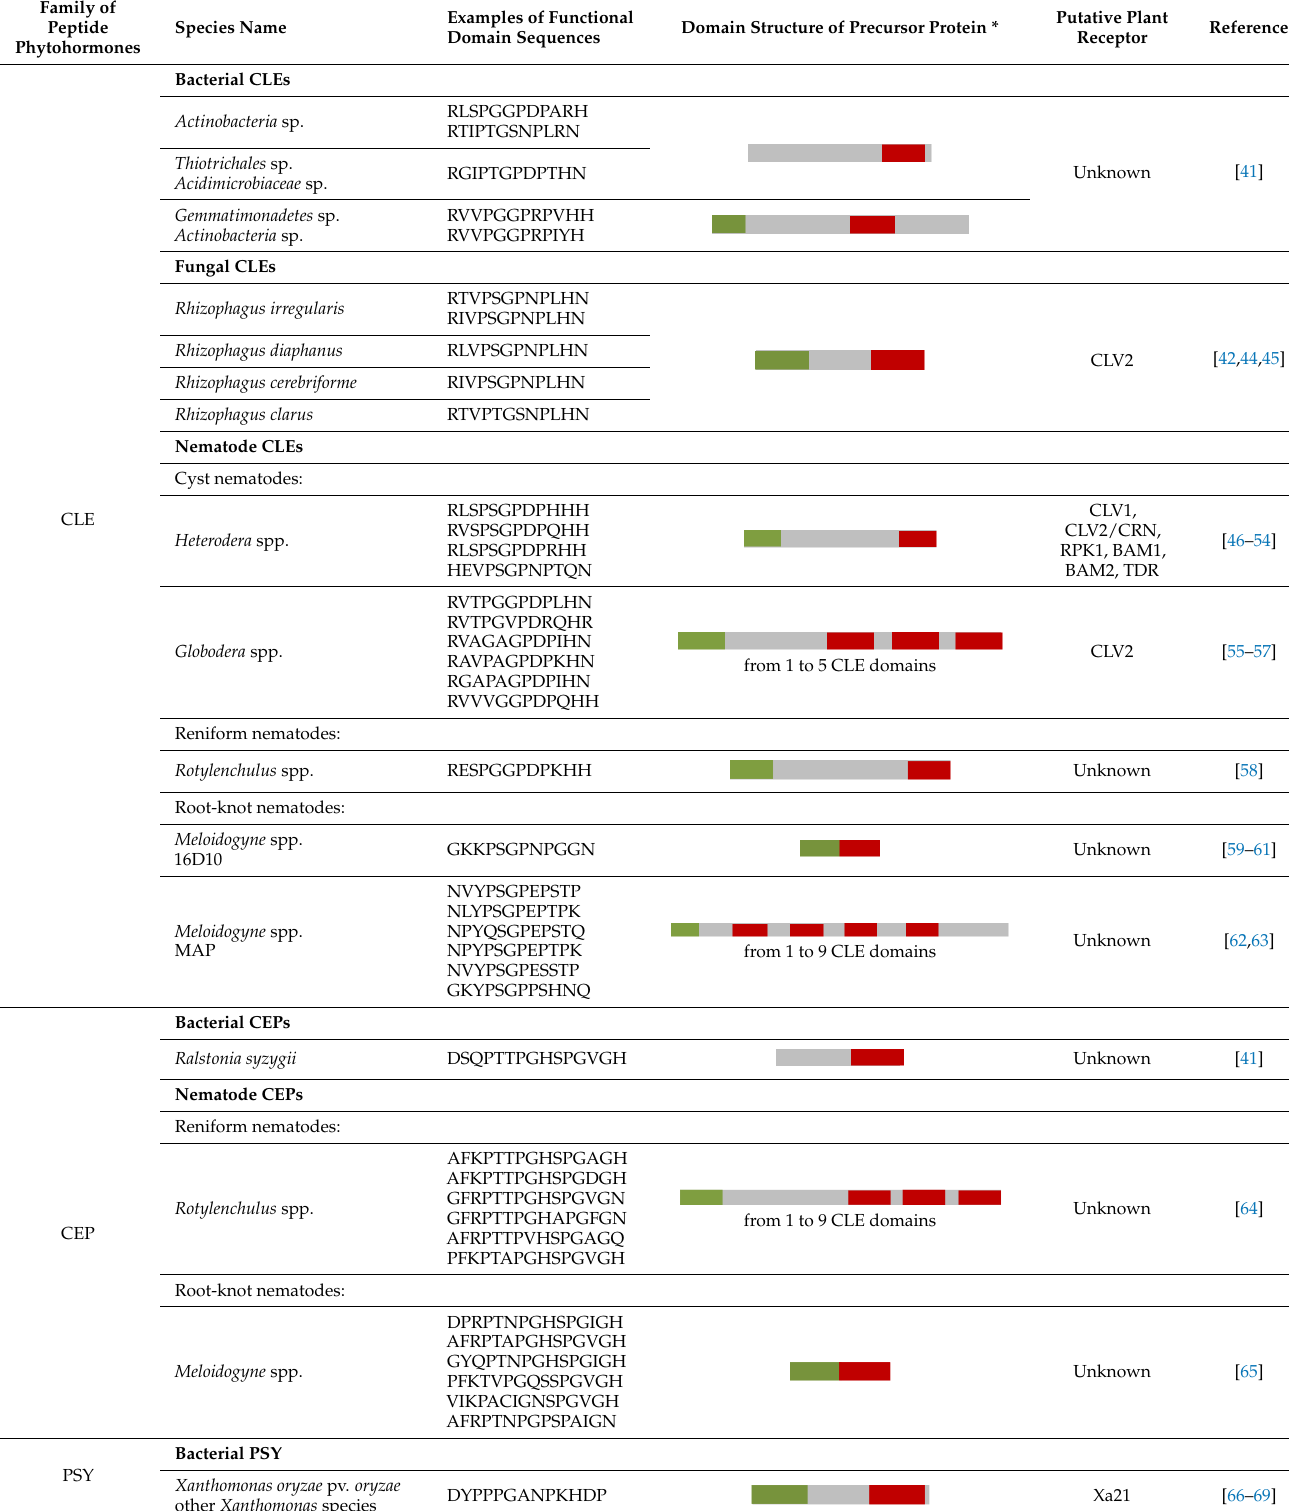
Table 1. Peptide phytohormones from plant-interacting bacteria, fungi, and nematodes: protein structure, functional domain sequences, and plant receptors.